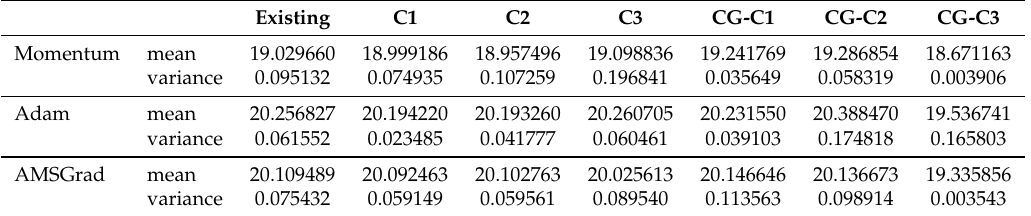
Table 3. Mean and variance of elapsed time per epoch for the existing algorithms and Algorithm 1 on the IMDb dataset.